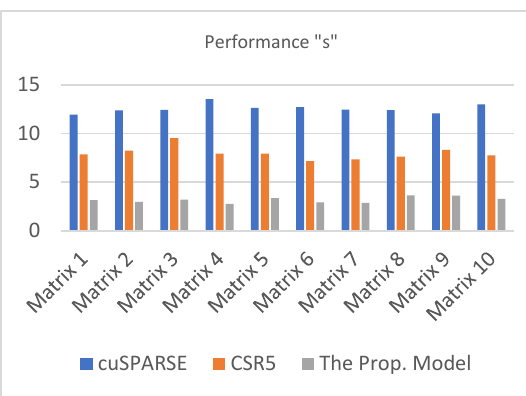
The Prop. Model Figure 7. Performance with block size of 32 using 10 different 1,048,576 by 1,048,576 CI sparse matrices.